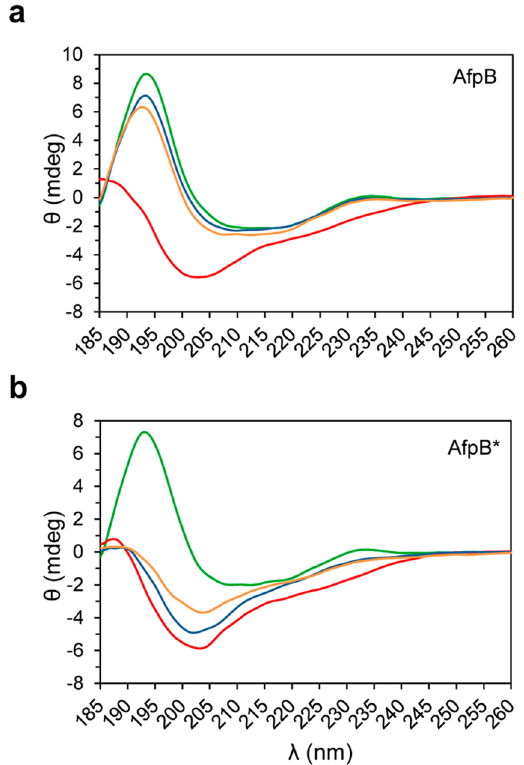
Figure 5. ECD spectra of the two recombinant protein variants produced in P . digitatum . ( a ) AfpB, and ( b ) AfpB * recorded at 25 °C (green), 95 °C (red), and at 25 °C immediately (blue), and 72 h (orange) after cooling from 95 °C to 25